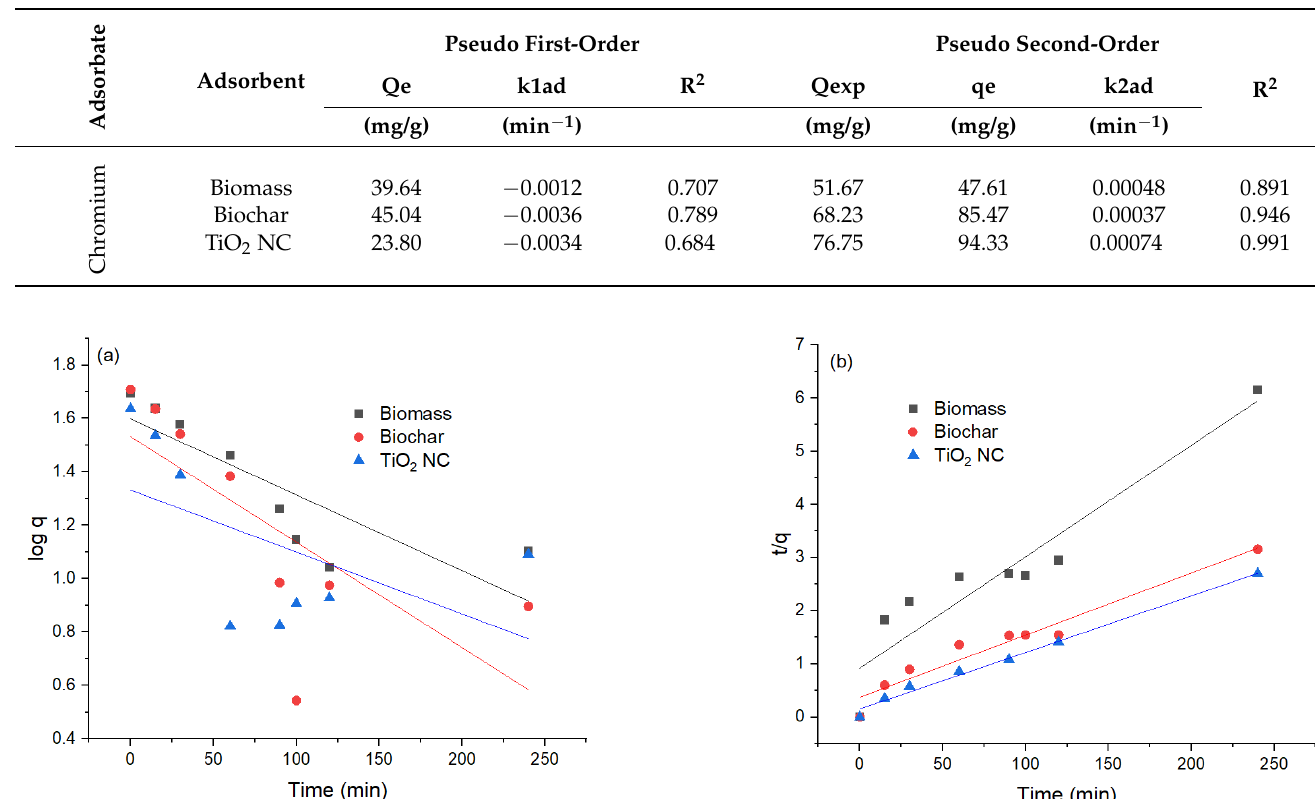
Table 3. Comparison of pseudo 1st-order and 2nd-order.